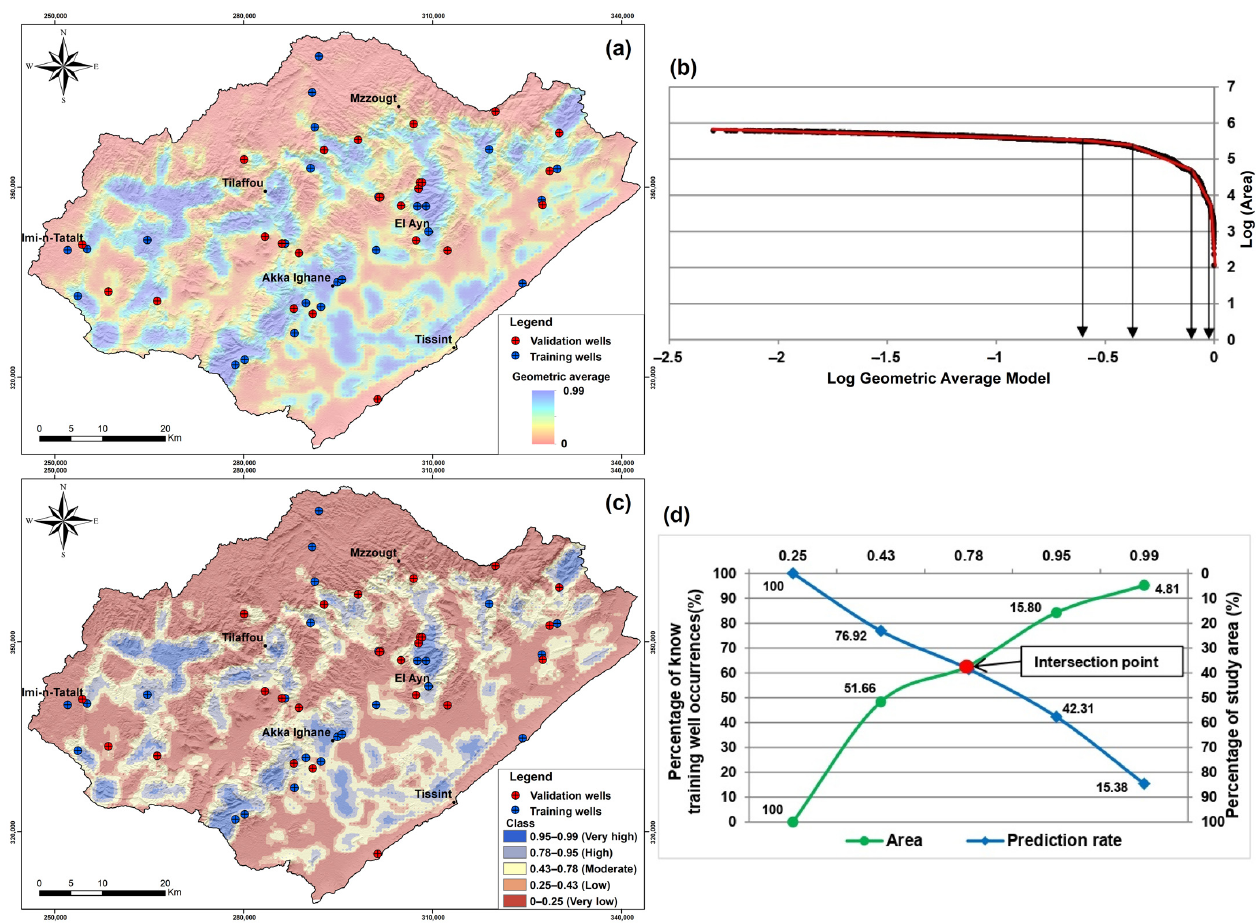
Figure 8. ( a ) Groundwater potentiality map of Tissent basin using the geometric average model; ( b ) Concentration-area (C-A) log-log plots of G A GWPA ; ( c ) Classified map of G A GWPA ; ( d ) Prediction–area (P-A) plot for the classed map of G A GWPA .